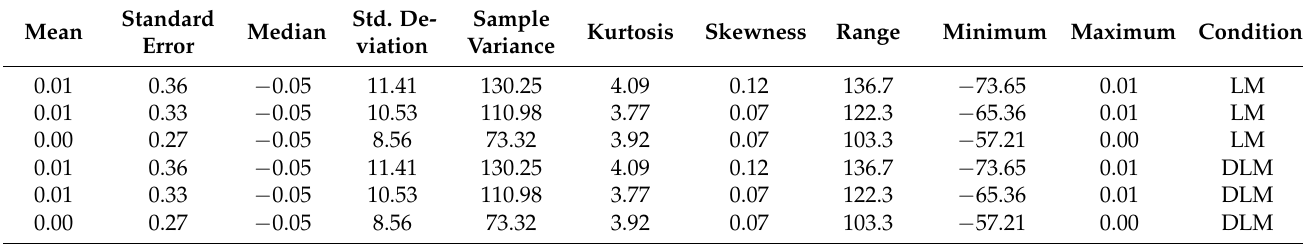
Table 3. Extracted features from the simulated data.